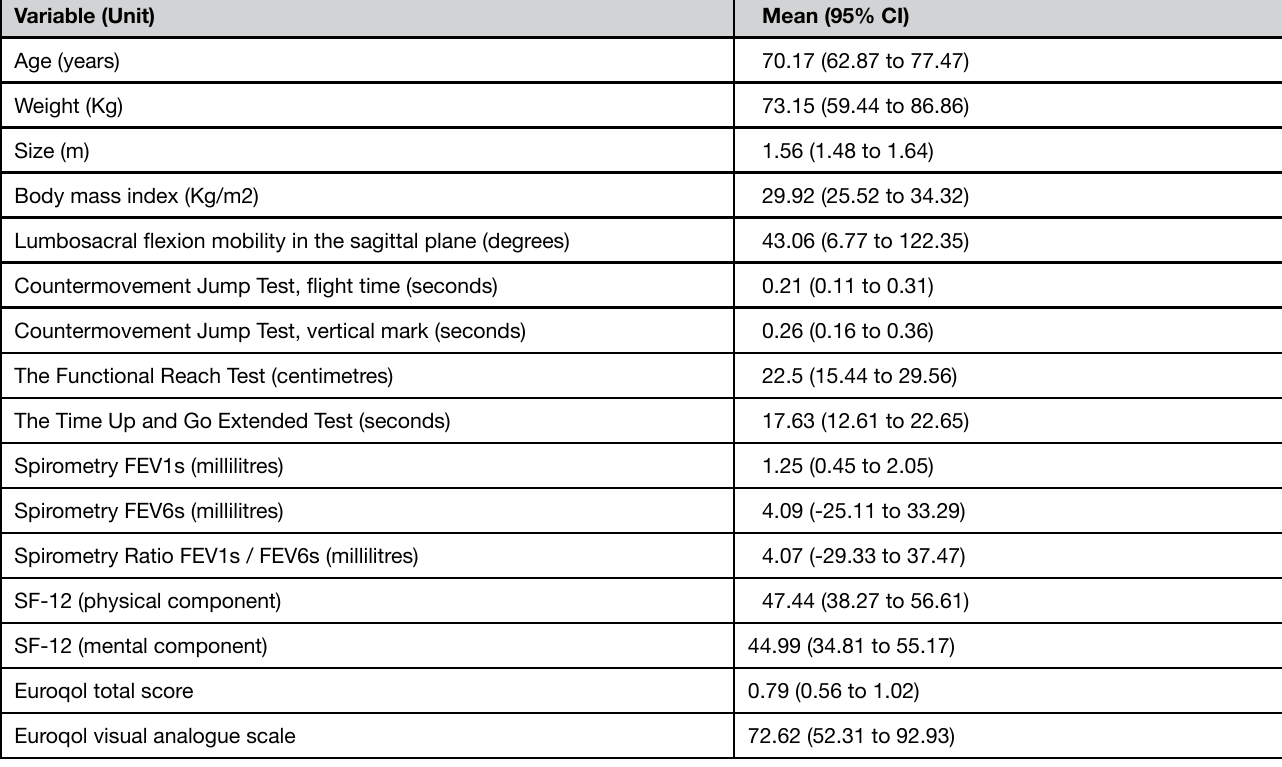
Table 2: Descriptive characteristics of the sample (n = 114).